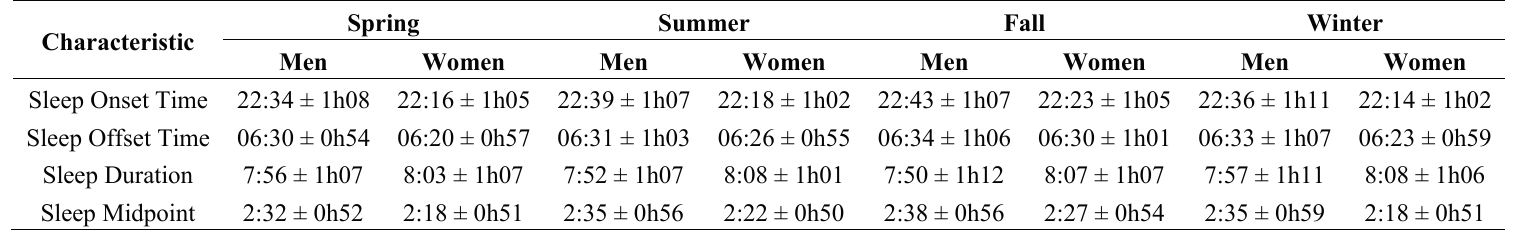
Table 2. Means of the dependent variables taken into account, according to season of birth. Spring Summer Fall Winter Characteristic Men Women Men Women Men Women Men Women Sleep Onset Time 22:34 ± 1h08